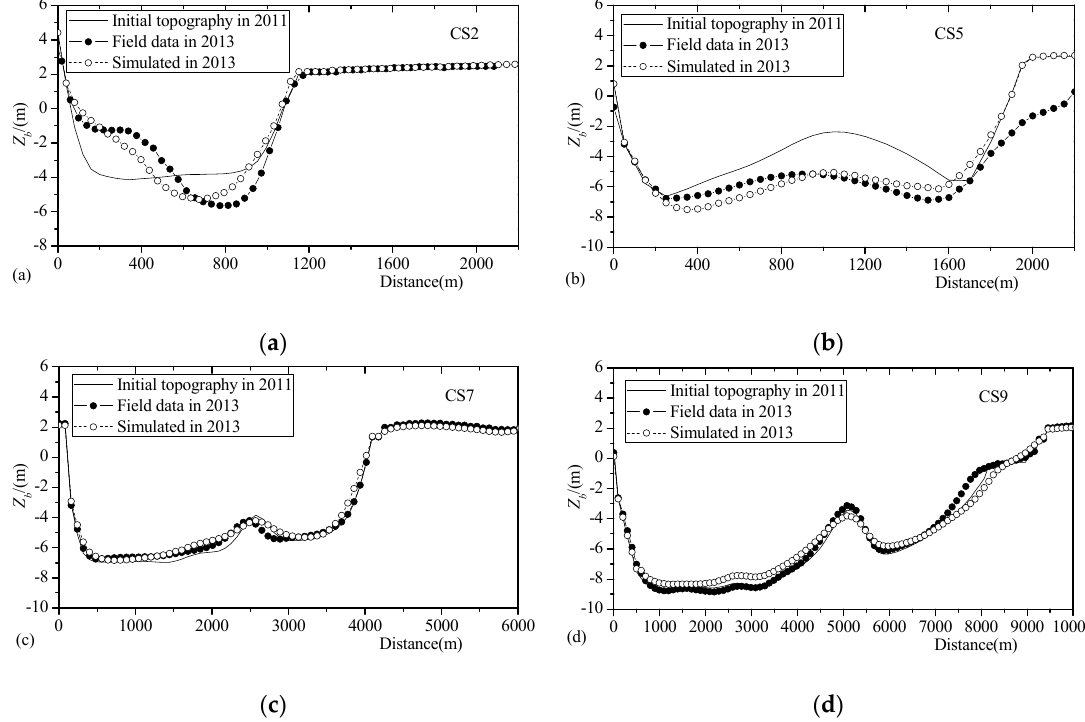
Figure 7. Comparisons of the simulated riverbed evolutions and field data at cross - sections. ( a ) at CS2, ( b ) at CS5, ( c ) at CS7, ( d ) at CS9.